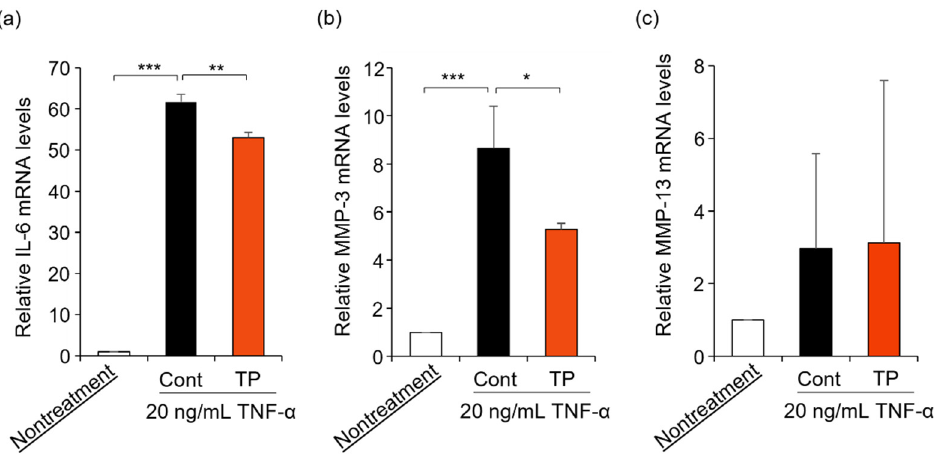
Figure 3. Effects of TP on the expression of IL-6, MMP-3 and MMP-13 mRNA in HFLS-RA cells stimulated with TNF- α . HFLS-RA cells were treated with 50 µ M TP in the presence of 20 ng/mL TNF- α for 24 h. IL-6 ( a ), MMP-3 ( b ) and MMP-13 ( c ) mRNA levels were determined by RT-PCR with specific primer sets. Values represent the means of three individual experiments. Bars represent SD. * p < 0.05, ** p < 0.01 and *** p < 0.001.